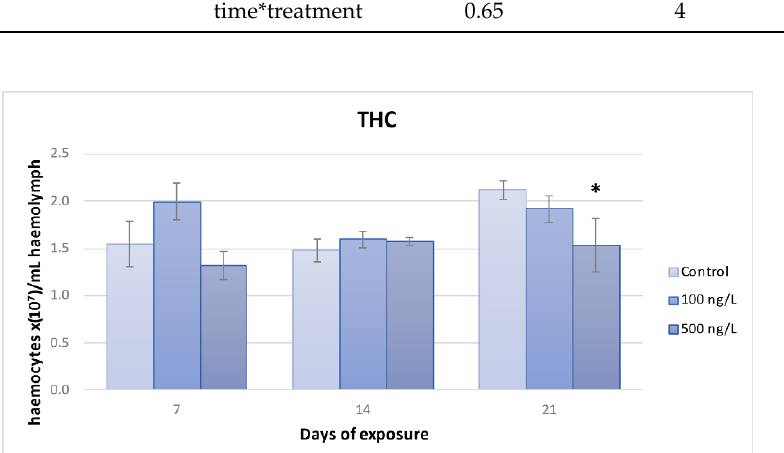
Figure 1. Total haemocyte count values in Ruditapes philippinarum after exposure for 7, 14 and 21 days to 100 ng/L and 500 ng/L of HHCB. The results are expressed as number of haemocytes × (10 7 )/mL of haemolymph and are reported as means ± standard error; n = 6. Asterisks indicate significant differences compared to controls at the same time of exposure: * p < 0.05.